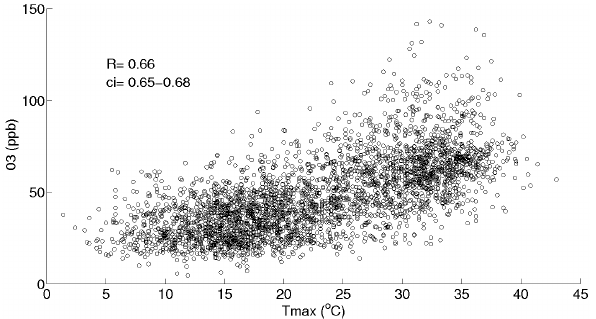
Figure 4. Number of days where daily maximum 8-h average ozone exceed 60 (red bars) and number of days where Tmax is above 17 0 C (blue line) for the 1990-1999 period.